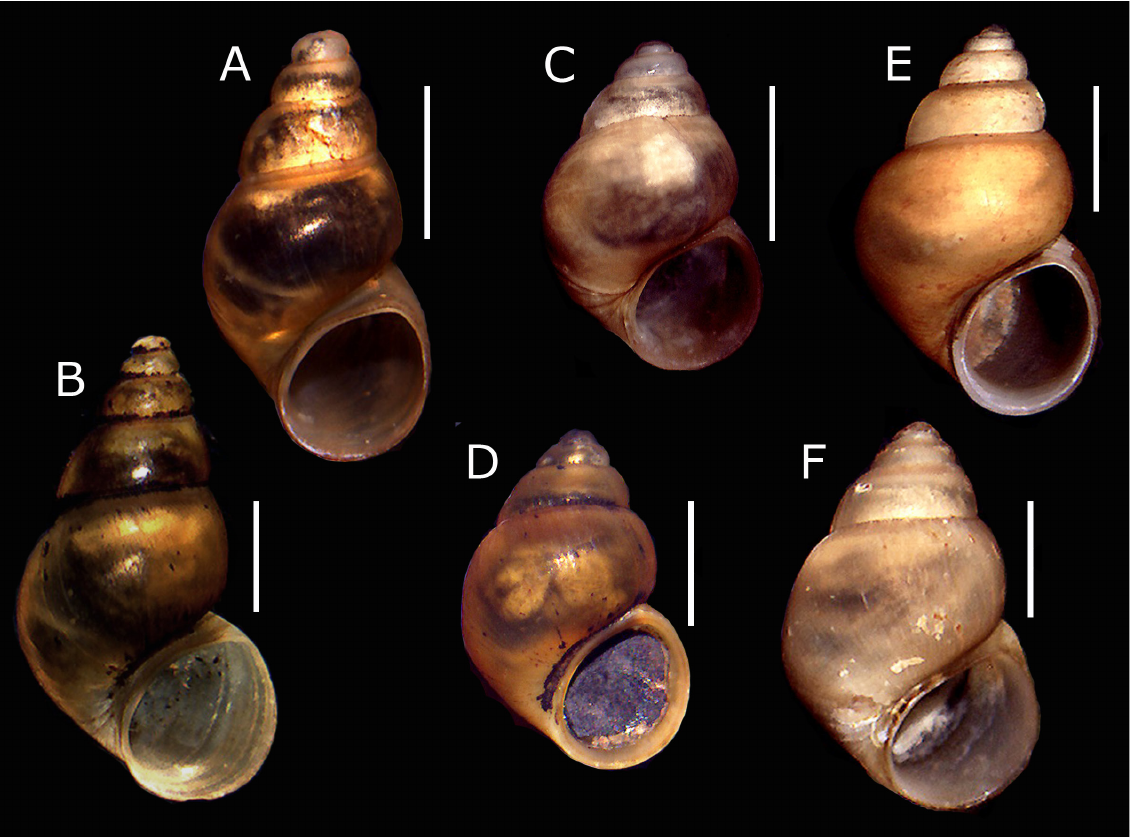
Fig. 2. Shells of truncatelloidean freshwater snails observed in the present study. A – B . Slender morphotype from El Yeso Spring (A) and Lo Carreño (B) assigned to Potamopyrgus antipodarum (Gray, 1843). C – E . Thicker morphotype from El Yeso Spring (C), Lo Carreño (D) and El Colorado (E) assigned to Potamolithus santiagensis (Biese, 1944) comb. nov. F . Thicker morphotype from Viña Casas del Maule assigned to Potamolithus sp. Scale bar = 1